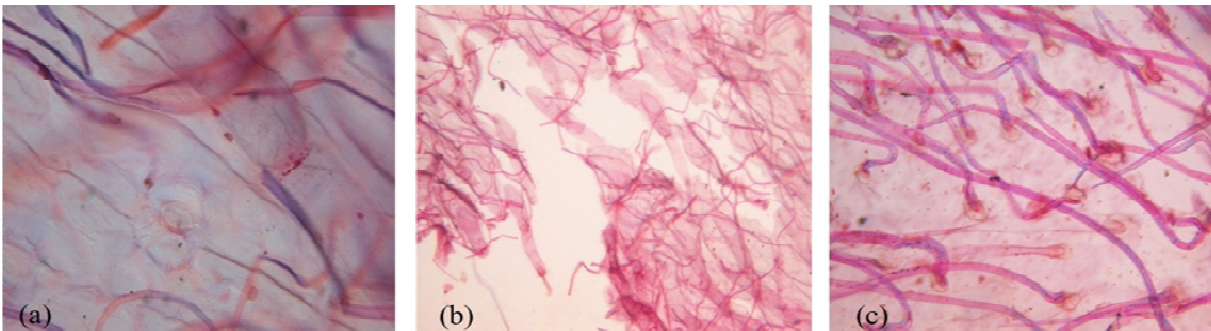
Fig. 6. a. Taraxacum officinale (Stomata); b. Taraxacum officinale (Trichomes); c . Astragallus